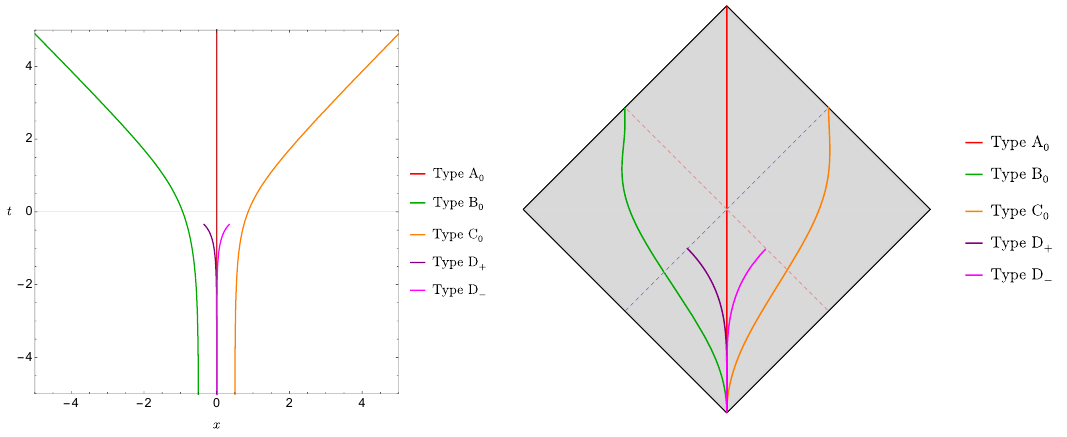
Figure 3 . Various trajectories for different types of simple moving mirrors associated with the mapping function p ( u )